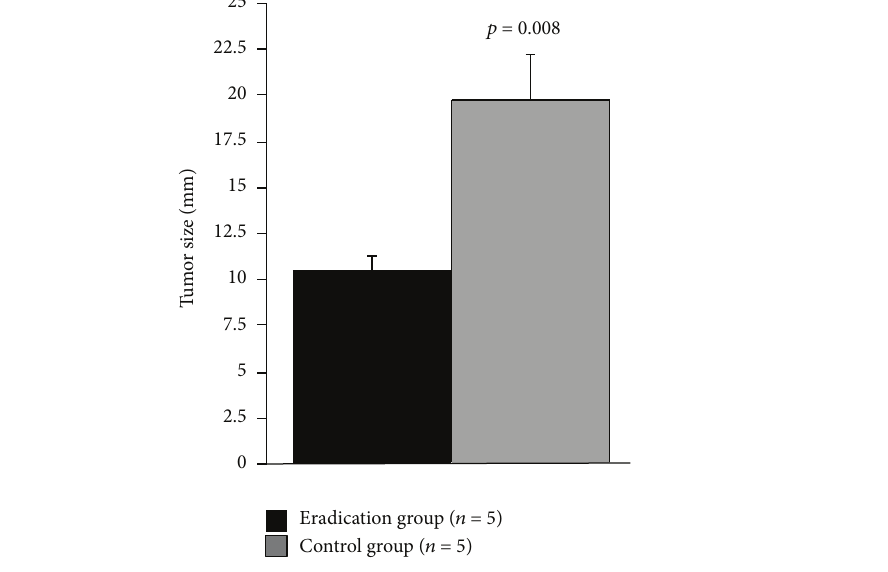
Figure 2: Comparison of lesion size of SM2 lesions among eradication and control groups. Statistical analysis was performed using the Mann-Whitney 𝑈